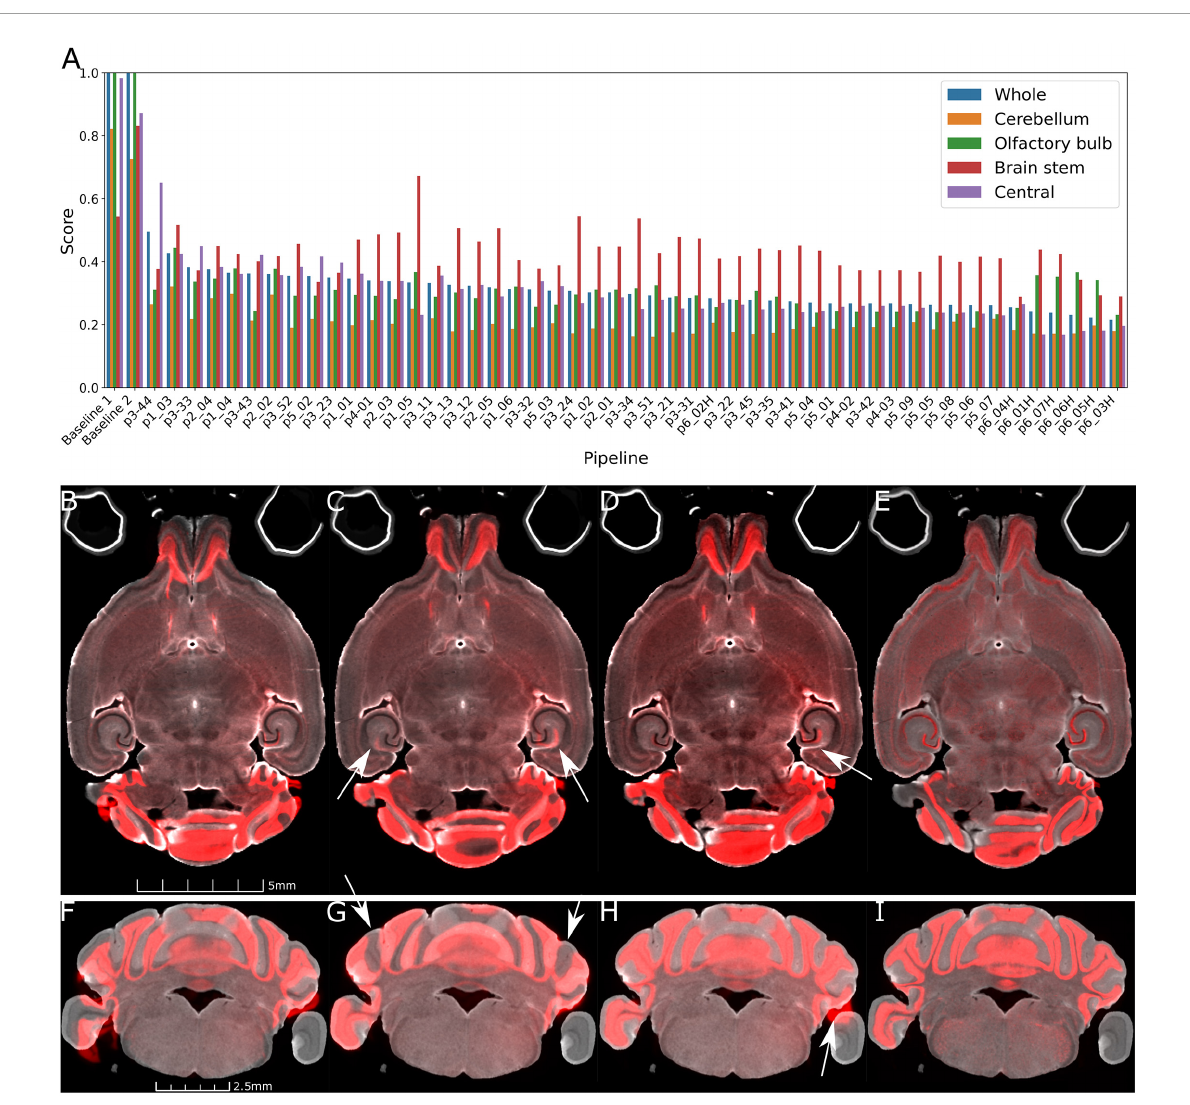
FIGURE3 Demonstration of the range of results derived from the varied pipes. (A) Shows the L2 norm for the pipes listed in Tables 2 , 3 registering Syto16 to DWI (specimen 191209). (B) Shows that the initialization results in reasonable alignment in the central slice. But (F) shows that initialization fails in the distal slices in the cerebellum. (C,D,G,H) Show results at 45 µ m with L2 norms of 0.361 using pipe P2_02. There are still significant errors in the cerebellum (arrows in panel G ). (D,H) With pipe P3_42 performs better with a lower L2 norm of 0.268. Finally, a comparison of panels (D,H) (@ 45 µ m) and (E,I) (@ 15 µ m) with pipeline P6_07_H demonstrates the utility of performing the registration using the higher resolution data. The cerebellar slice in panels (F–I) highlights a frequent problem i.e., loss of the parafloculoss from handling. The